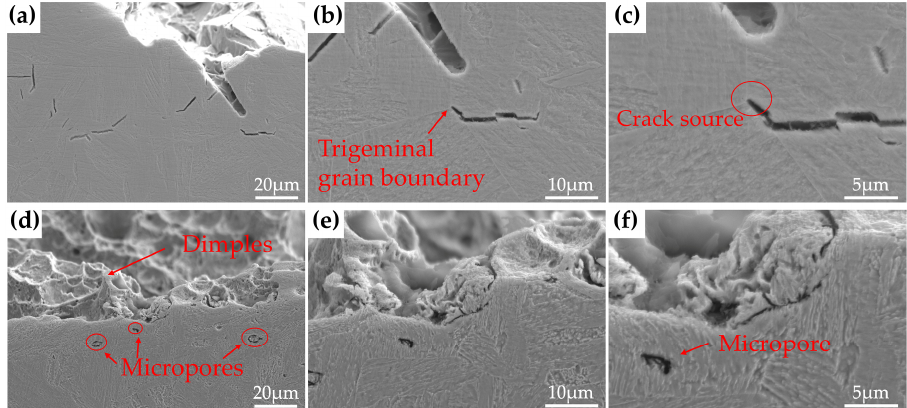
Figure 5. SEM images of different magnification for the cross ‐ sectional areas adjacent to the impact fracture surfaces of 3Cu ‐ steel tempered at different temperatures: ( a – c ) 450 °C; ( d – f ) 600 °C.